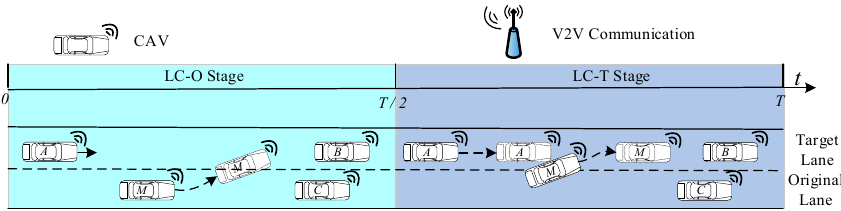
Figure 2. The two stages of the lane change.